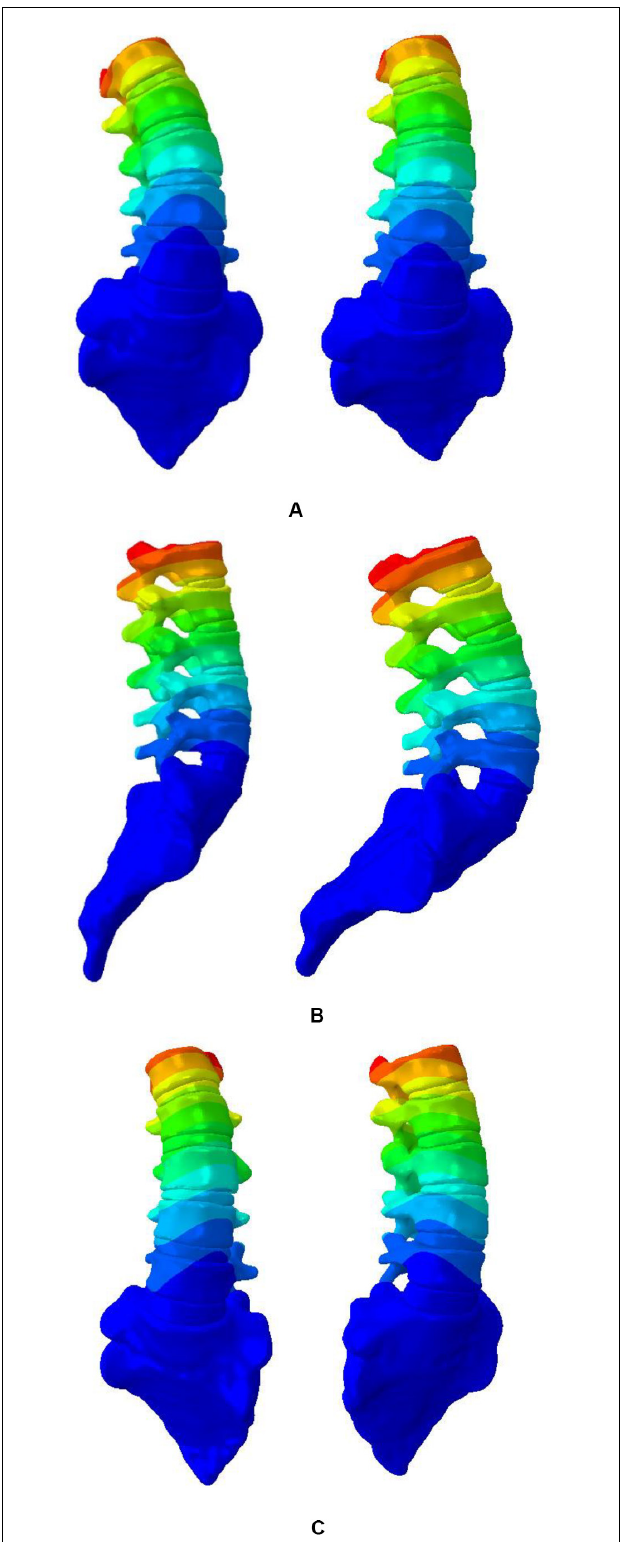
FIGURE 4 | Displacement nephogram. (A) Left and right side bending, (B) Flexion and extension, and (C) Twist around.